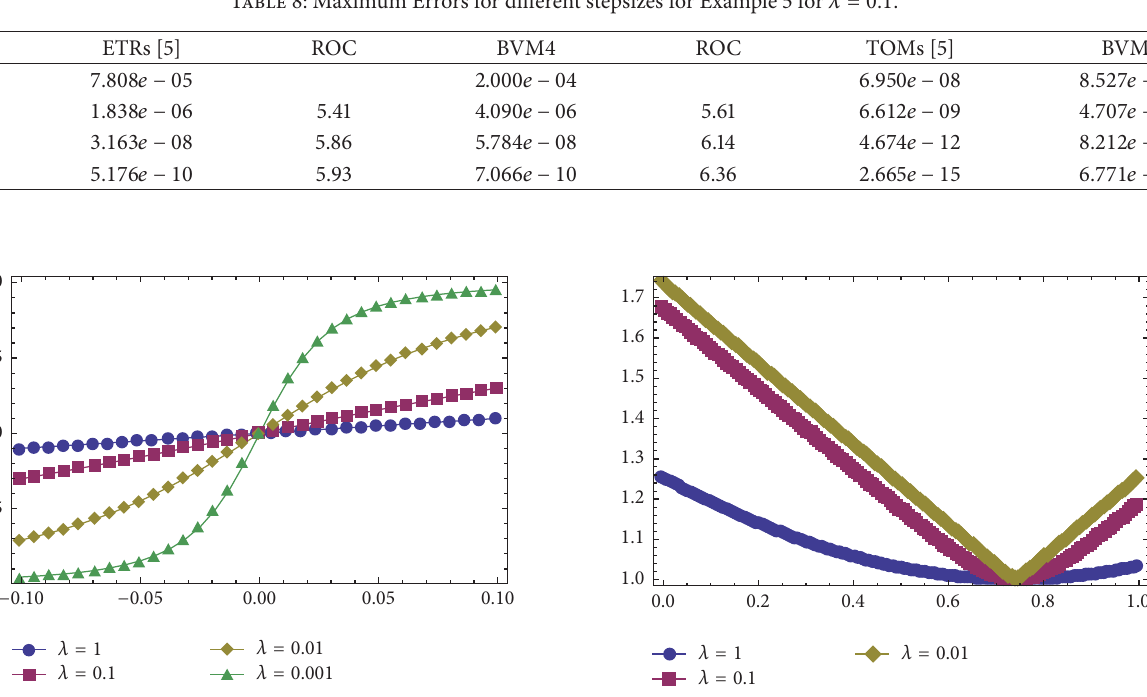
Figure 4: Plot of solution for Example 4. Figure 5: Plot of solution for Example